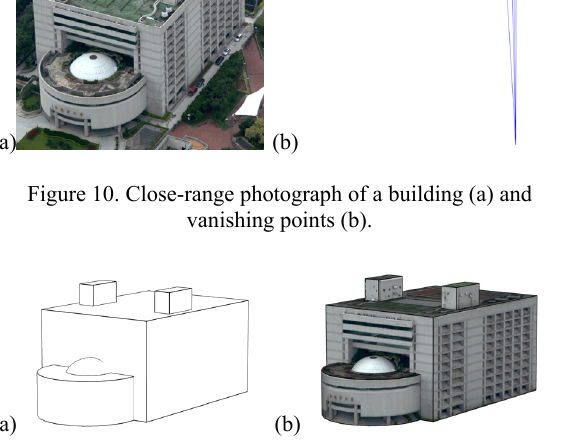
Figure 11. Reconstructed model from close-range photograph (a) wireframe (b) textured with raw image. Figure 9. (a) Reconstructed free-form shape structure (b) curved hip parameters.